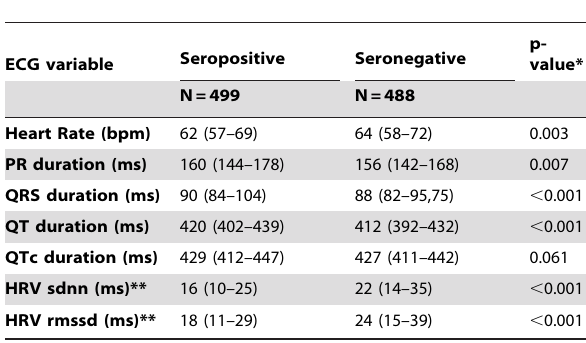
Table 2. Quantitative ECG measurements in T.cruzi seropositive and seronegative